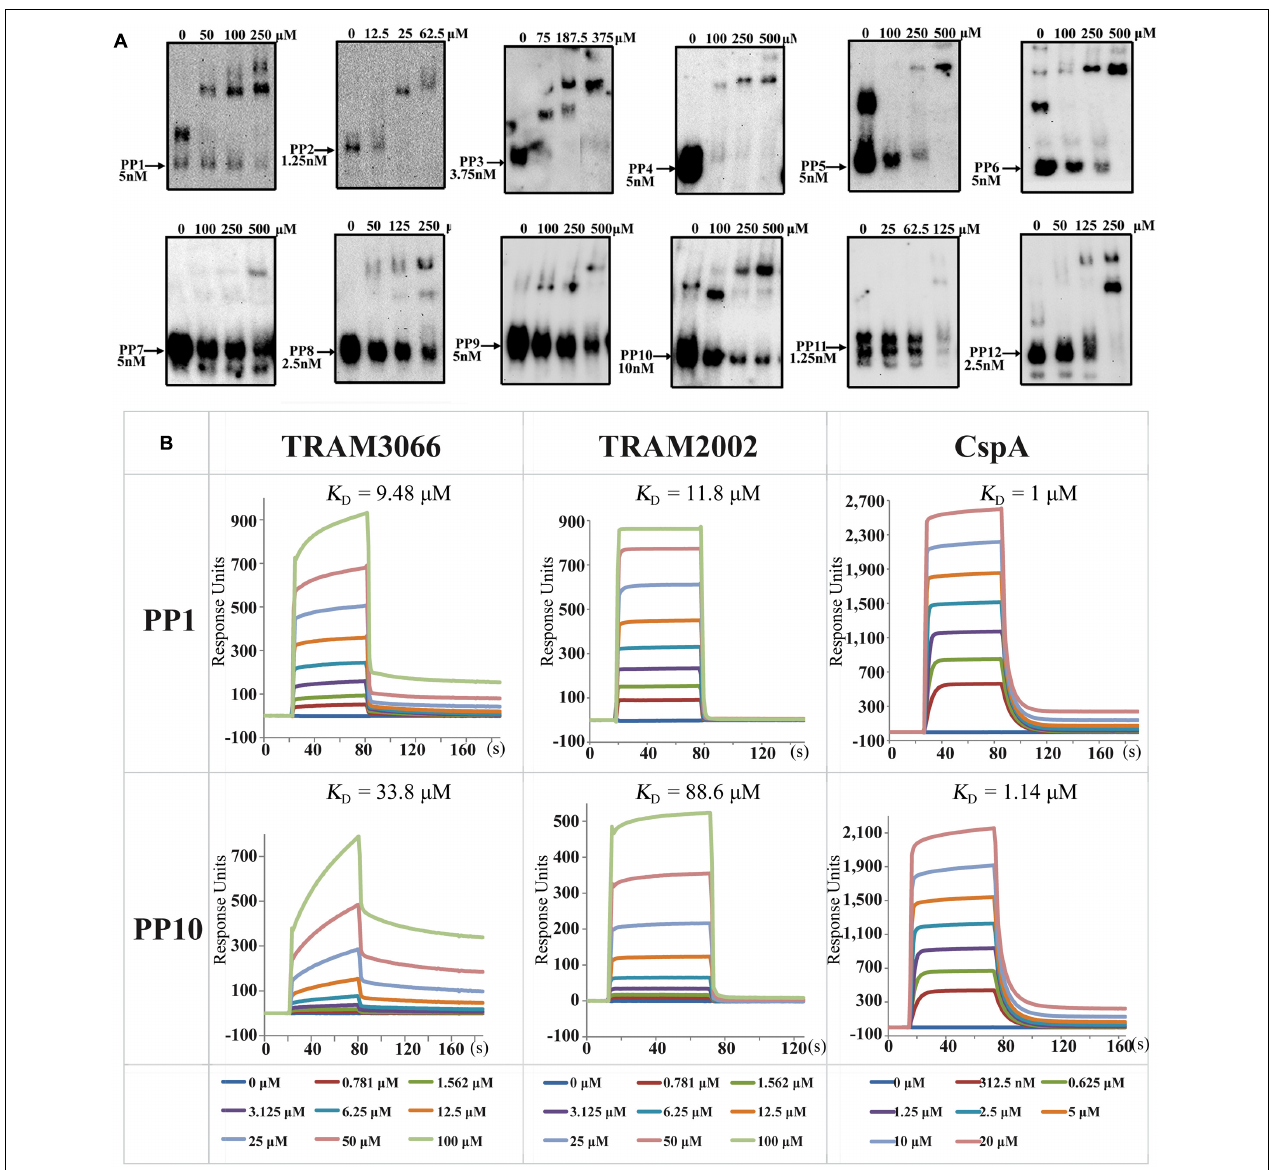
FIGURE 4 | Determination of TRAMs in binding RNA. (A) RNA-EMSA (rEMSA) was performed to assay the sequence specificity of TRAM3066-binding RNA. Twelve of the RNA Pentaprobes (PP) (Bendak et al., 2012) were 3 (cid:48) biotinylated and used as substrates. Purified TRAM3066 was added to the binding mixture at the indicated concentrations. Arrows point to the RNA probe and its concentration. (B) Surface plasmon resonance (SPR) assayed the binding affinity of TRAM3066 and TRAM2002 to the selected RNA PP1 and PP10. E. coli CspA is included as a reference. Calculated K D values are shown in the corresponding diagrams for each pair of protein-RNAs. The protein concentrations for each reaction are color-coded and labeled in the bottom rows. s,